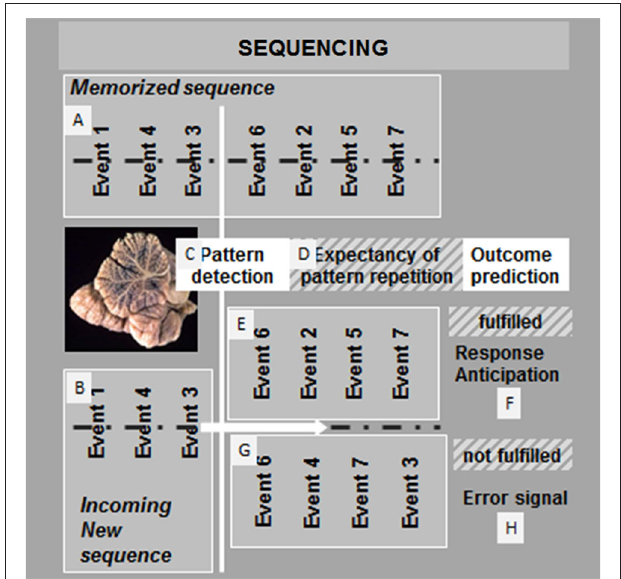
FIGURE 1 | Proposed mechanism of cerebellar sequencing for prediction . Incoming events are continuously monitored in the cerebellar circuits. Relations between events are compared in the cerebellar corticonuclear microcomplex (Ito, 2005) and stored in a working memory buffer (A) . Through the same mechanisms, sequences of new incoming events are compared with previously stored event sequences (B) . If a match is recognized (C) , then an expectancy of repetition is generated (D) . The cerebellar monitoring of the flow of events continues, and as long as the prediction is maintained (E) , response anticipation is conveyed, and feedforward control can function smoothly (F) . If prediction fails (G) , then an error signal is activated by the cerebellar output system (H) , and feedforward control is interrupted or